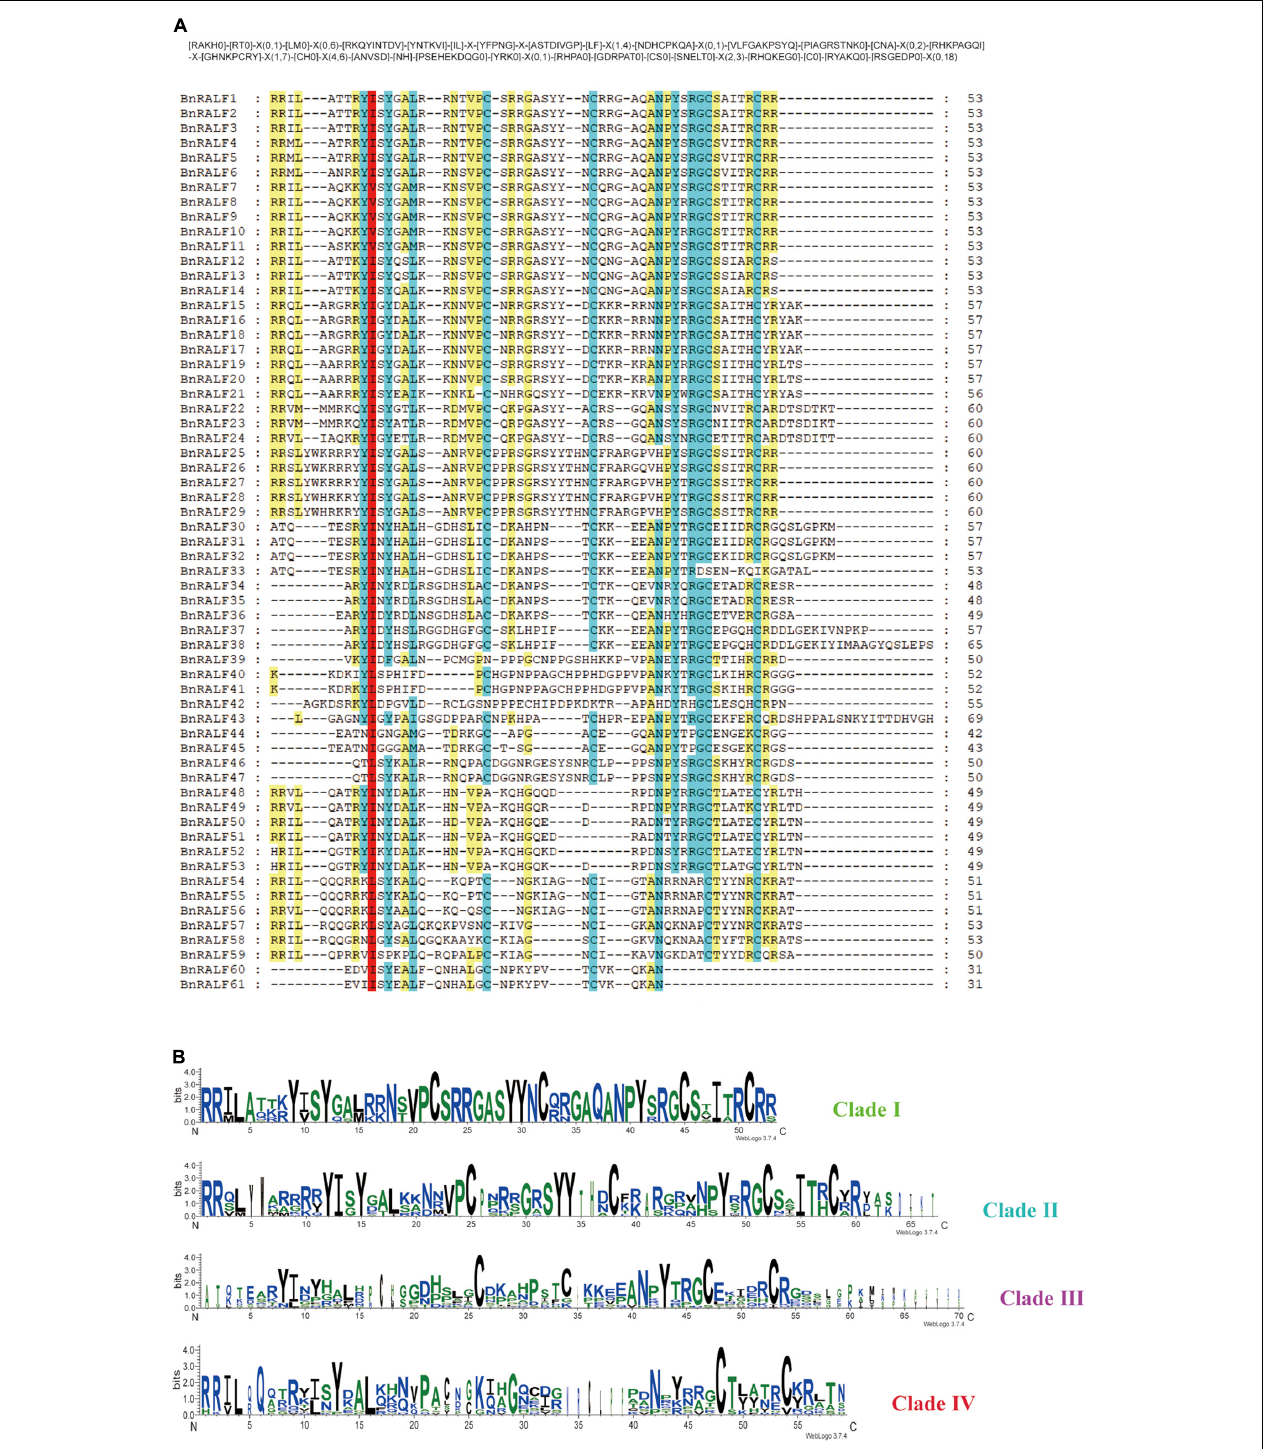
FIGURE 2 | Conserved motifs of B. napus RALF proteins. (A) Multiple sequence alignment of BnRALF proteins for conserved motifs. Alignment was carried out using ClustalW and presented by GeneDoc. Residues with various conservation percentage were highlighted in different colors: 100% in red; 80 ∼ 100% in blue, 60 ∼ 80% in yellow. The square bracket ‘[ ]’ indicates the amino acids allowed in this position of motif; A ‘X’ represents any amino acid, while the round bracket ‘()’ denotes the number of amino acids. (B) Residue conservation of BnRALFs within the clades. The group-wise sequence logos showing the amino acid bias of the RALF mature peptides were generated from the WebLogo3 analysis. Y -axis expresses the bit score of each position in the sequence and the group names are indicated on the right.